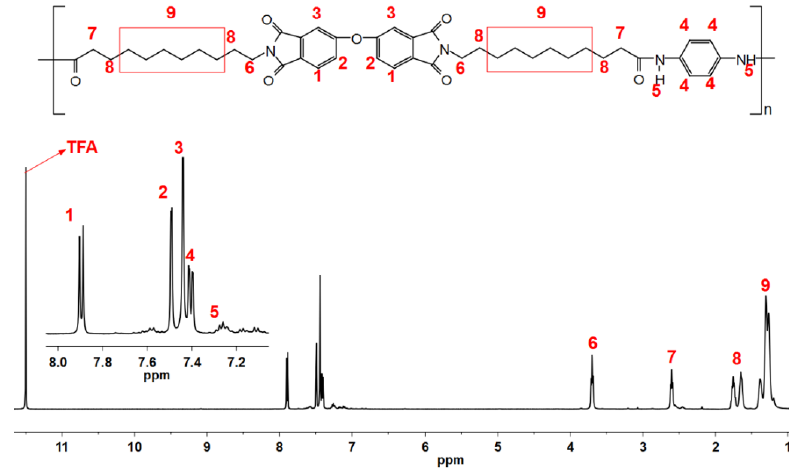
Figure 3. H-NMR spectrum of poly(amide-imide).